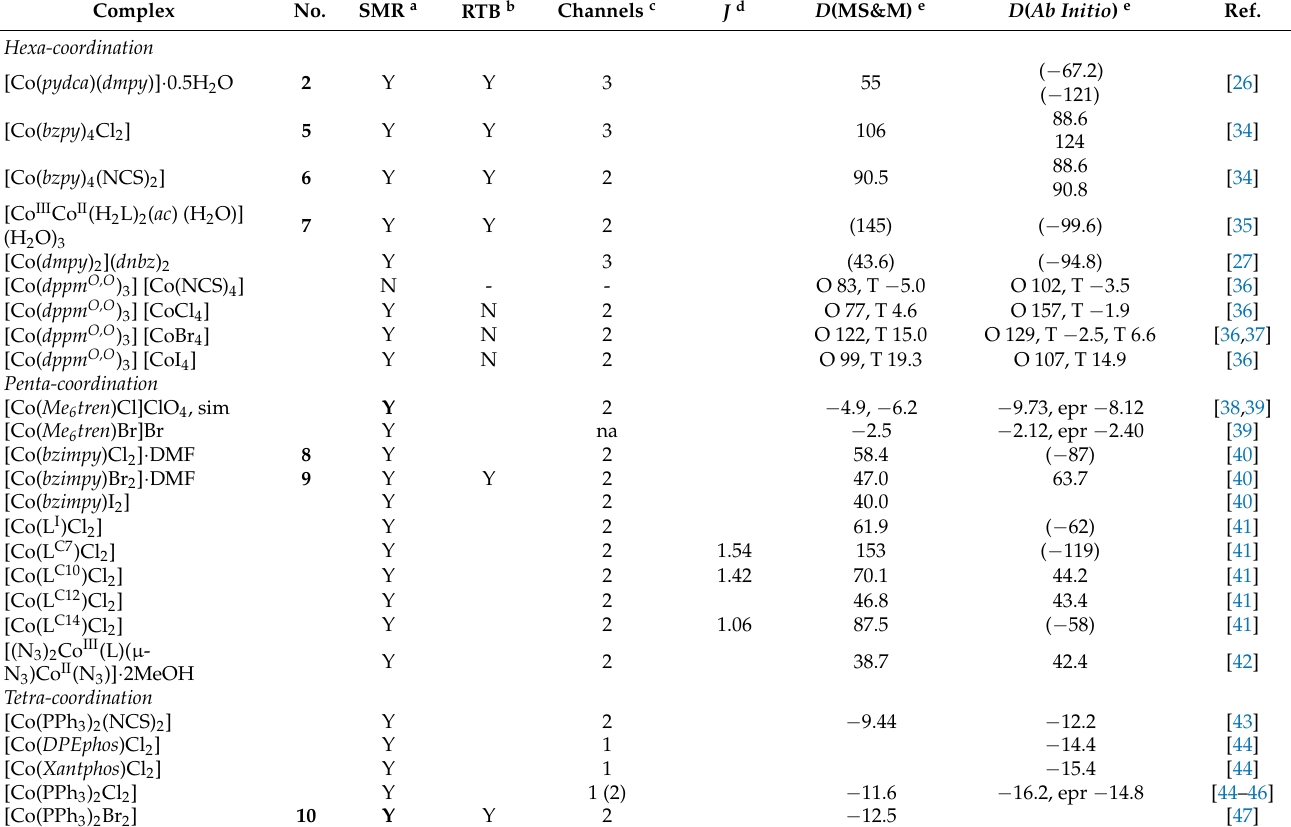
Table 2. Comparison of selected Co(II) complexes showing